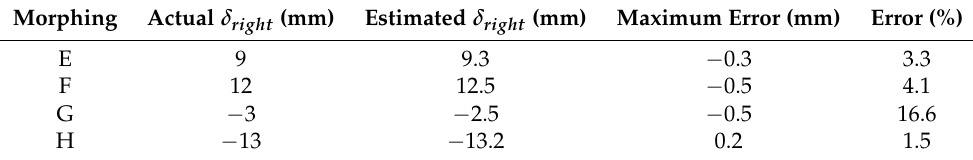
Table 7. Model estimated right deflections of the wing during twisting due to arbitrary morphing E to H.